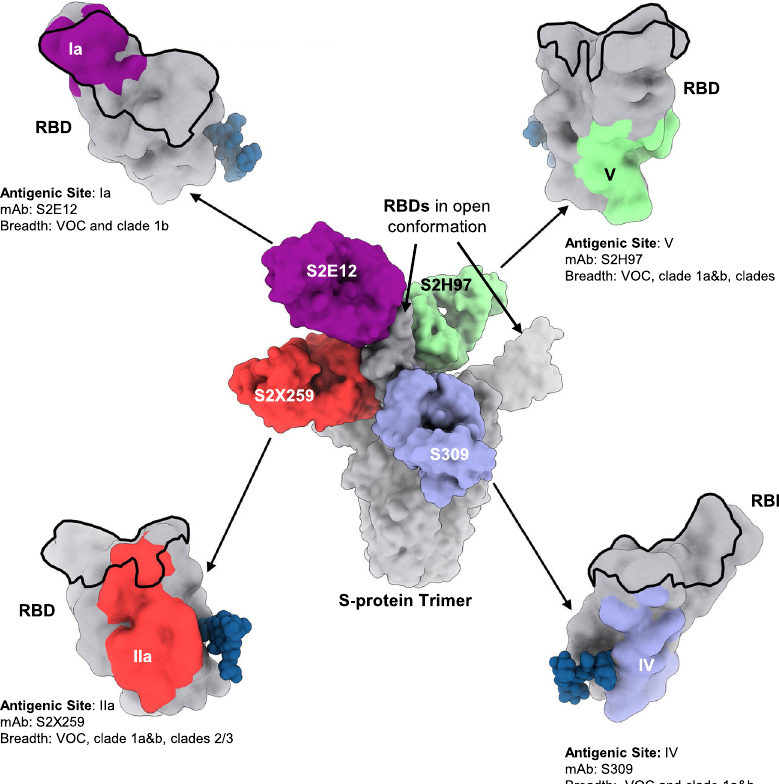
Fig. 2 Overview of SARS-CoV-2 RBD cross-neutralizing antigenic sites. Center panel: composite model of the SARS-CoV-2 S-protein trimer (gray) with four distinct monoclonal antibodies (S2E12 in purple, S2X259 in red, S2H97 in green, and S309 in blue) bound to one RBD in the open conformation. Top and bottom, left and right panels: magni fi ed model of RBD (gray) with the ACE2-binding site outlined in black and the respective mAb cognate epitopes indicated by color. In dark blue is a surface representation of the glycan at position N343, which is conserved across the sarbecovirus subgenus. Top left: antigenic site Ia (purple) is targeted by the S2E12 mAb, which neutralizes the VOC and clade 1b, SARS-CoV-2-related, sarbecoviruses 29 . Bottom left: antigenic site IIa (red) is targeted by the S2X259 mAb, which inhibits ACE2 binding, neutralizes the VOC and clades 1a&b SARS-CoV-2-related sarbecoviruses, and binds to clades 2/3 sarbecoviruses 30 . Bottom right: antigenic site IV (blue) is targeted by the S309 mAb, which neutralizes the VOC and clades 1a&b SARS-CoV-2-related sarbecoviruses 27,35 . Top right: antigenic site V (green) is targeted by S2H97, which neutralizes the VOC and clades 1a&b SARS-CoV-2-related sarbecoviruses, and binds to clades 2/3 sarbecoviruses 34